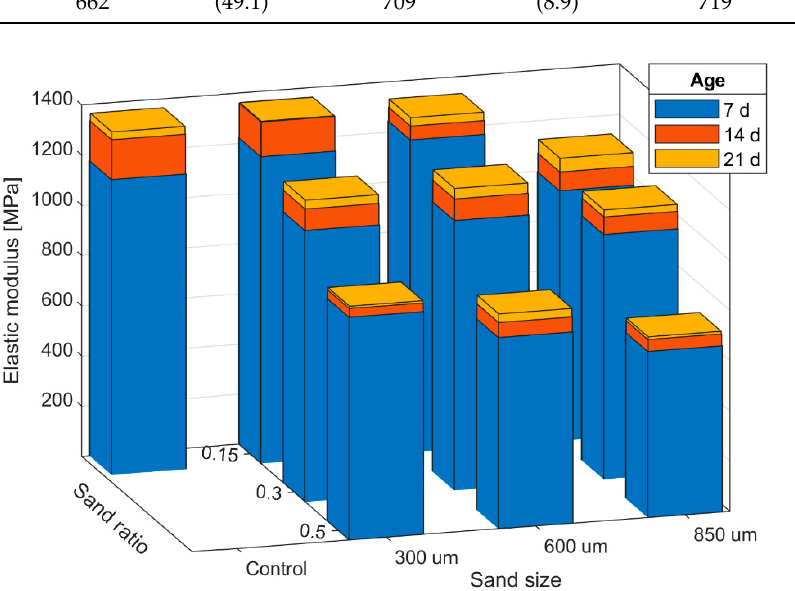
Figure 1. Comparison of the elastic modulus results for all samples.